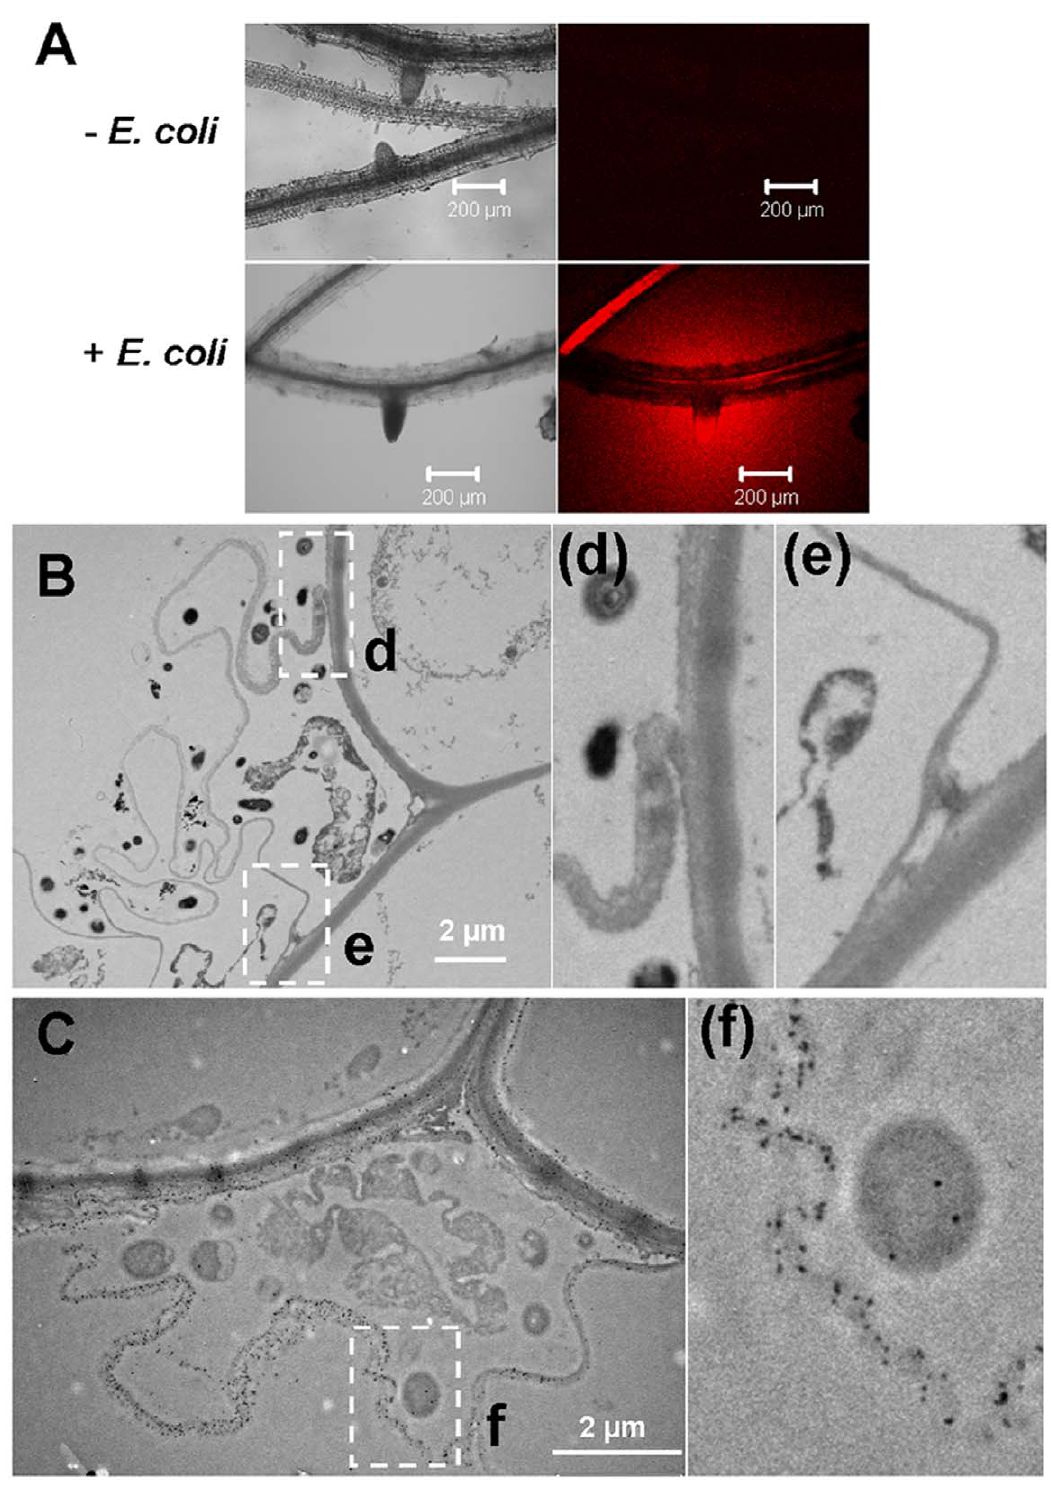
Figure 4. Root produced cellulase and extended the cell wall when incubated with E.coli Bl21. (A) Incubation of Arabidopsis roots in 31 m g/mL resorufin cellubioside after incubating overnight with E. coli . After 2 h incubation, roots were viewed by CLSM. (B) TEM image of cell wall- like structure of plant roots encompassing bacteria. (C) TEM image of cellulase-gold labeling on the root sections with double labeling with the anti- GFP antibody. The size of the gold particle on bacteria is 15 nm (Au-particle specific to GFP E. coli ) and gold particles on the plant material are 10 nm (Au-particle specific to plant cellulose). (d), (e) and (f) are detail images of insets d, e and f.